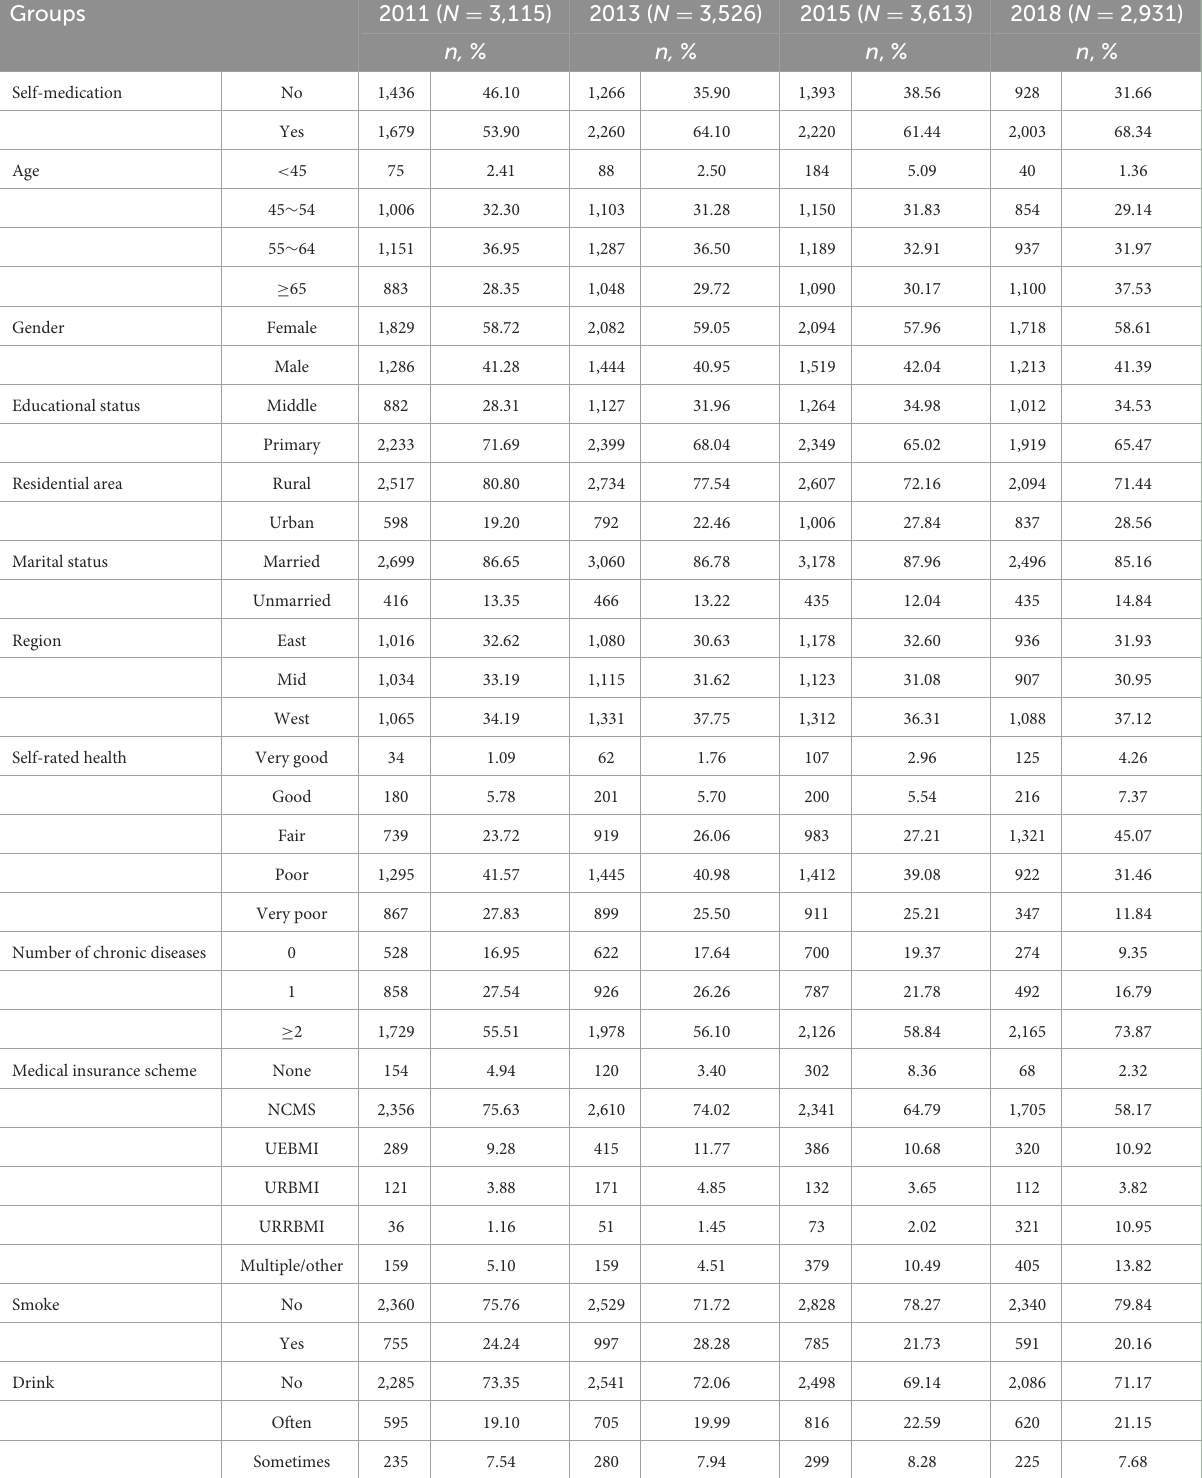
TABLE 1 Demographic characteristics of outpatients ( N = 13,185).